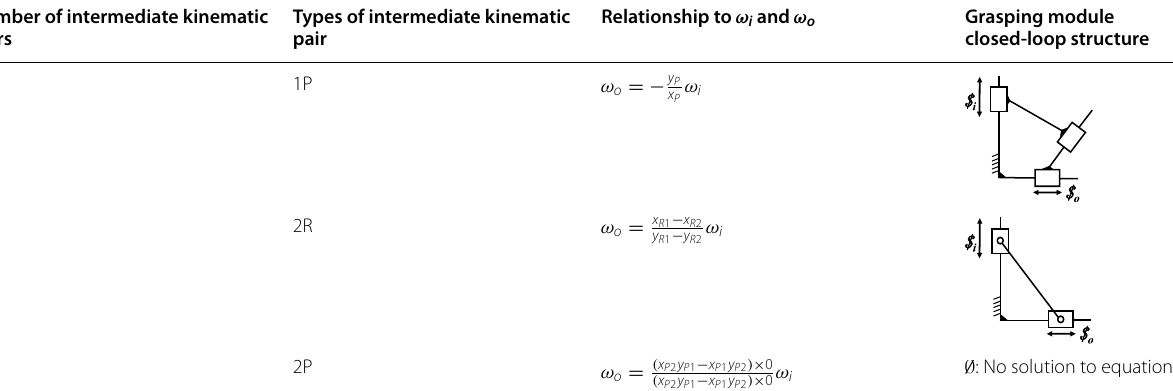
Table 3 Closed-loop structure of grasping module for prismatic output joint Number of intermediate kinematic pairs